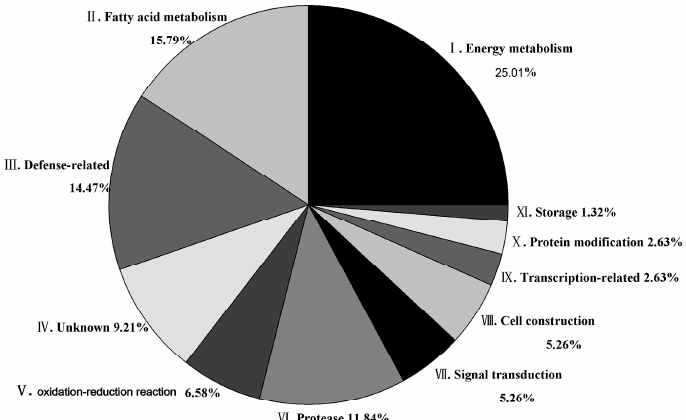
Figure 4. The functional proportion of the identified proteins expressed in the tung tree seeds during the three developmental stages. A total of 76 identified differential proteins were assigned to functional categories. The Roman numeral in each category corresponds to the functional category described in Supplementary Materials Table S1. The percentage represents the proportion of each category.